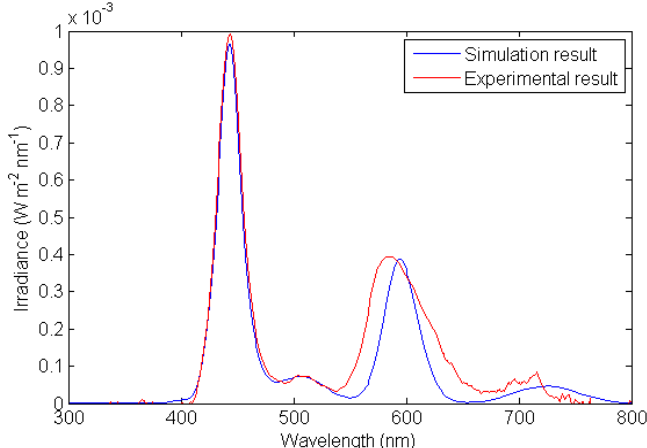
Figure 18. Simulation result versus experimental result for the case without any